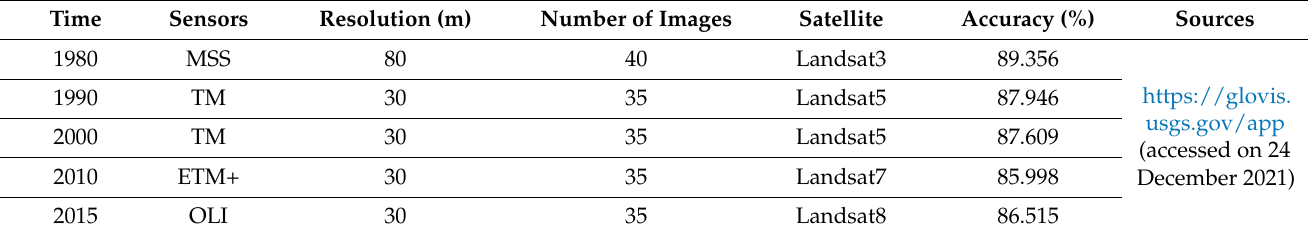
Table 1. Satellite data for this